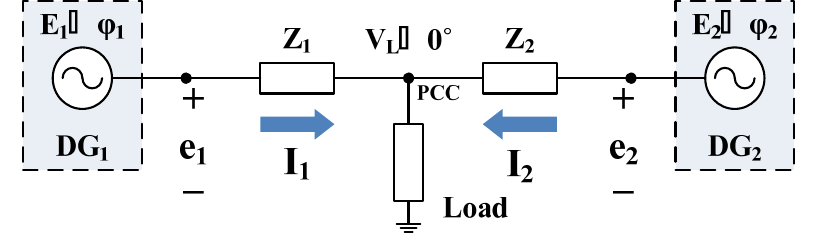
Figure 2. Equivalent circuit for two parallel operated DGs.